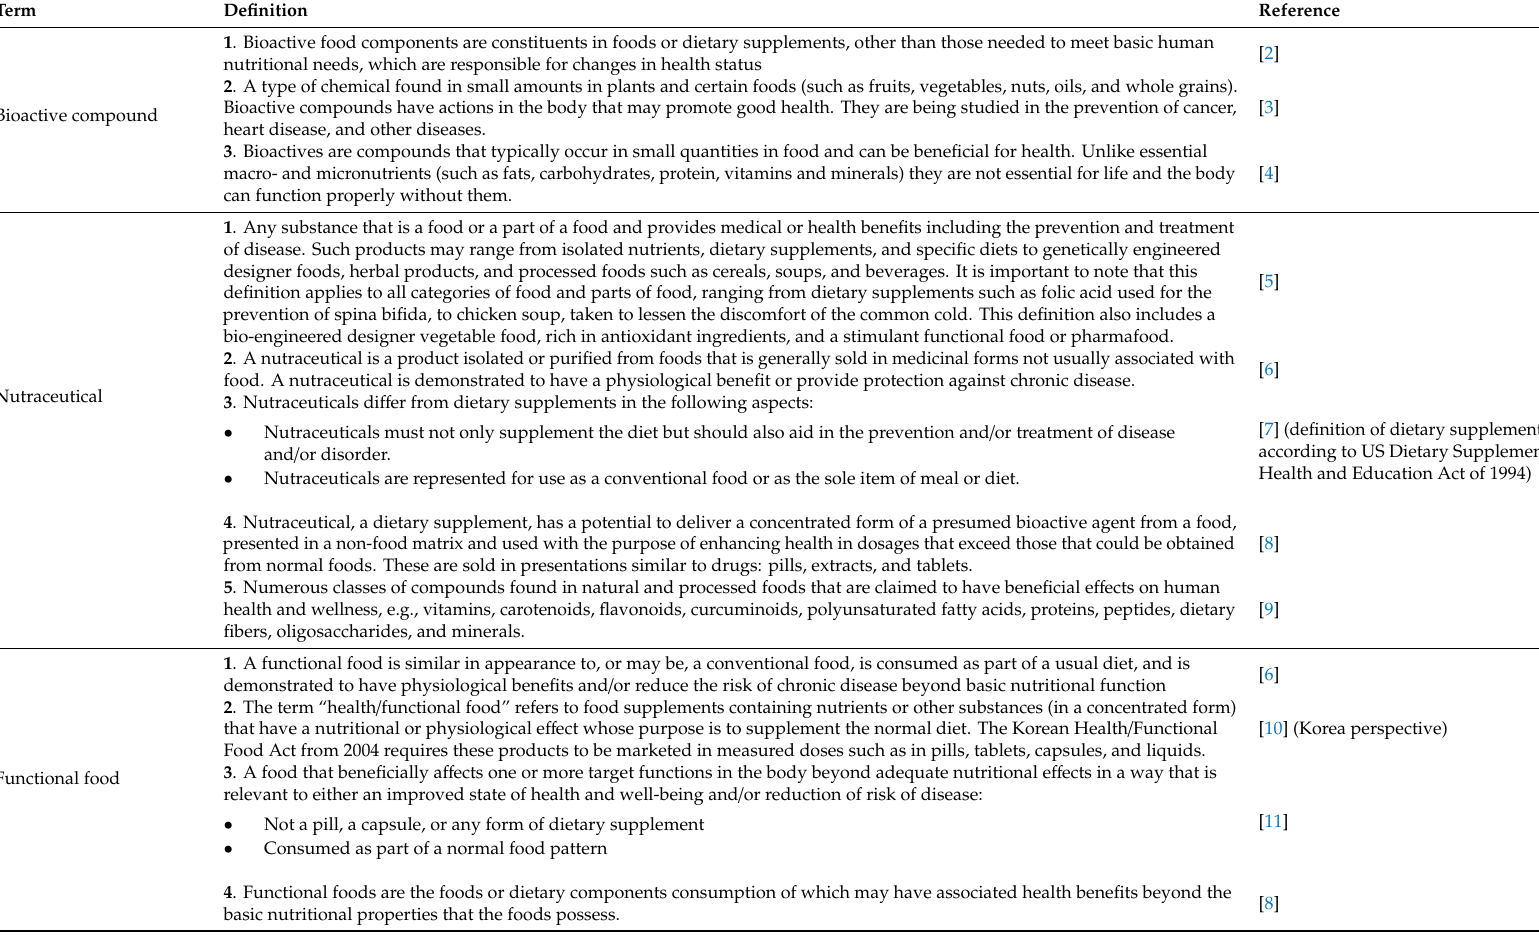
Table 1. Non- exhaustive list of definitions found in the published